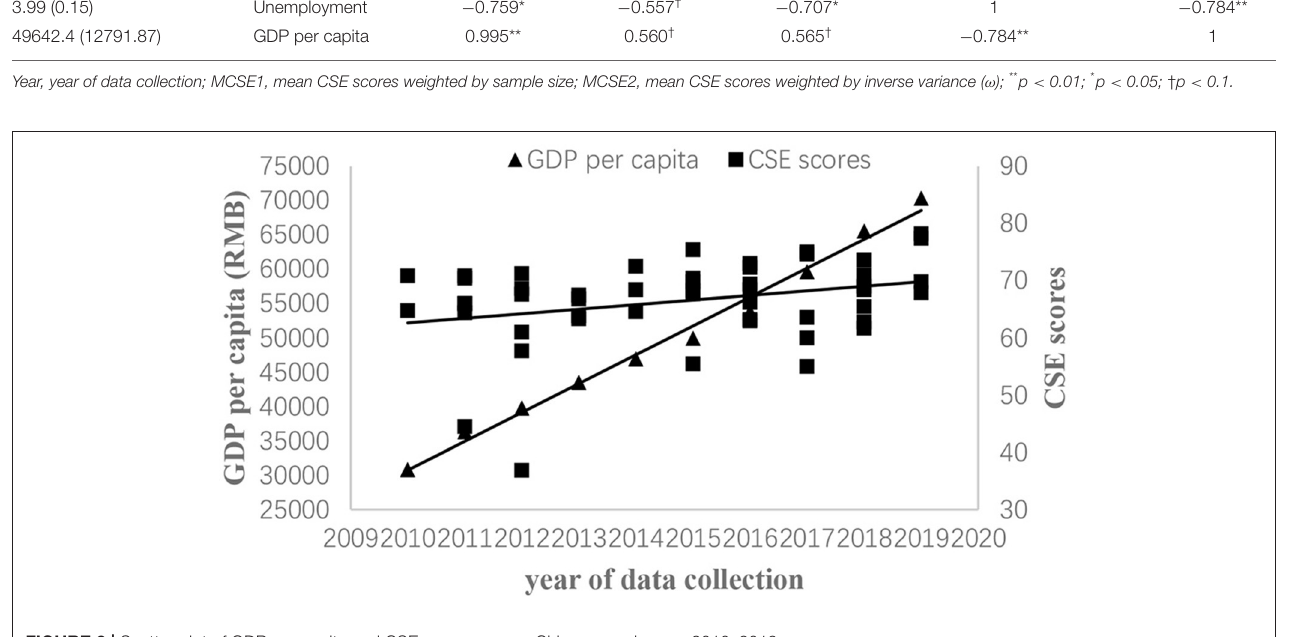
FIGURE 2 | Scatter plot of GDP per capita and CSE scores among Chinese employees,